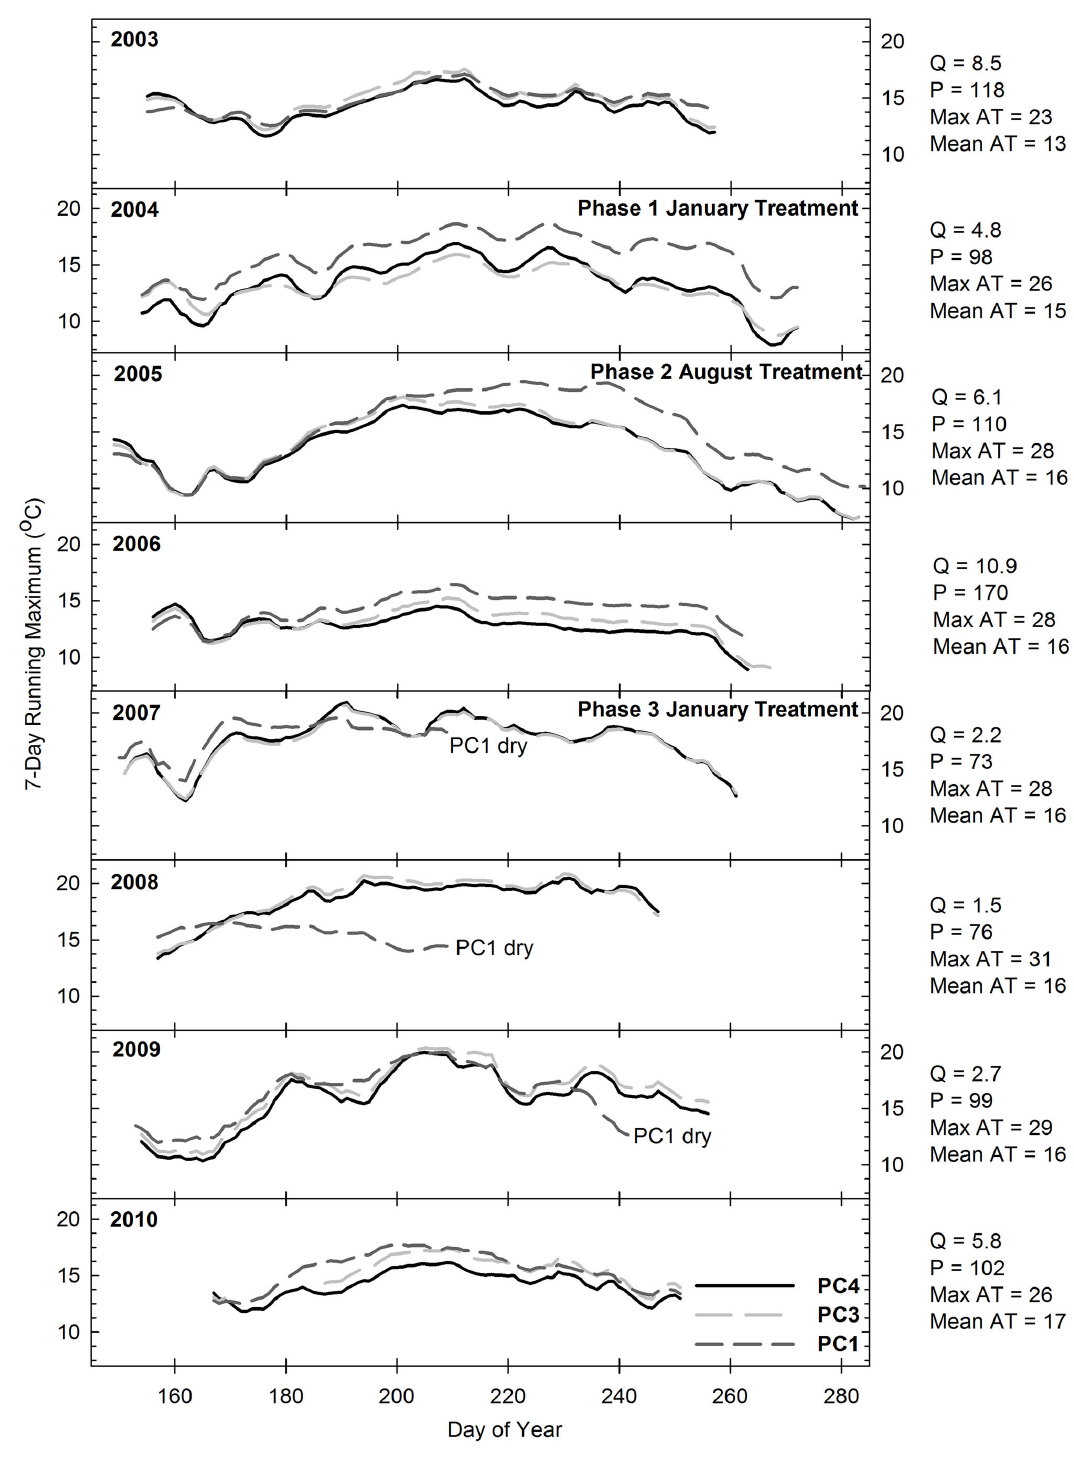
Figure 5. Seven day running average daily maximum water temperature (°C) on Pine Creek. Station PC4 was located immediately upstream of the areas treated during Phases 1-3. Station PC3 was located immediately downstream of the areas treated during Phase 1, and station PC1 was located immediately downstream of the areas treated during Phases 2 and 3. Q = mean discharge (m 3 min -1 ) from Jun 15 – Aug 31, P = percent of mean annual precipitation, Max AT = mean of daily maximum air temperature (°C) from Jun 15 – Aug 31, AT = mean of average daily air temperature (°C) from Jun 15 – Aug 31. doi: 10.1371/journal.pone.0084561.g005 PLOS ONE |